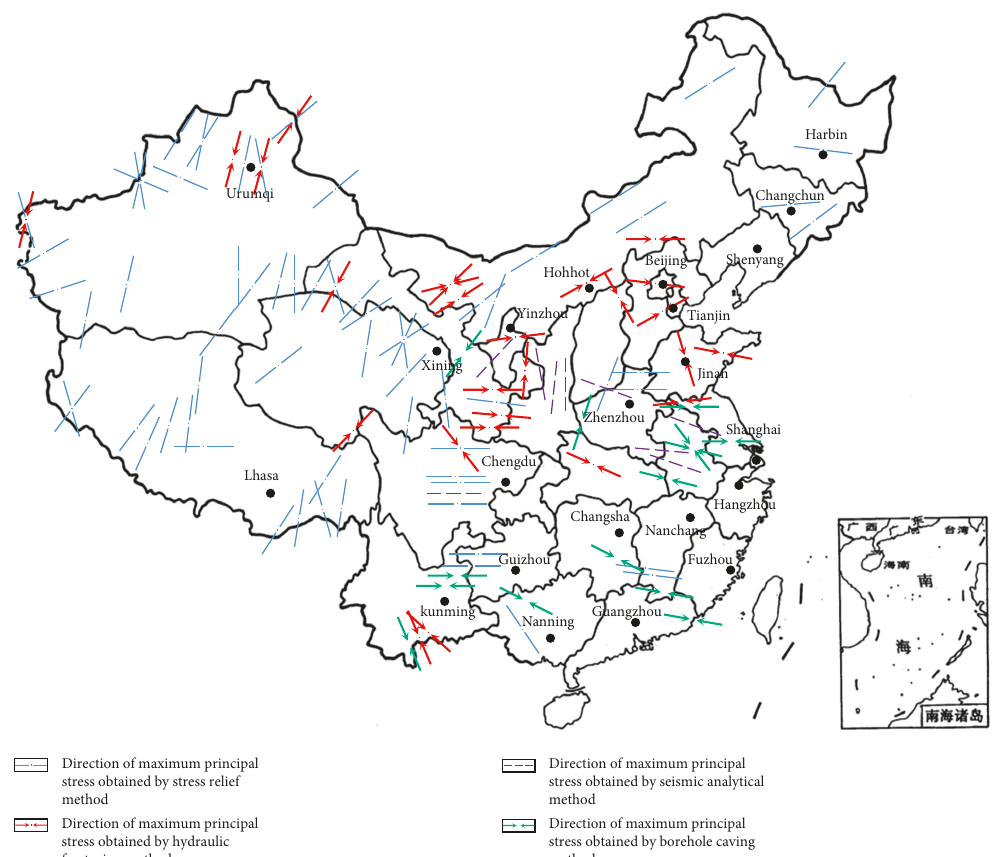
Figure 2: Current in situ stress zoning in China